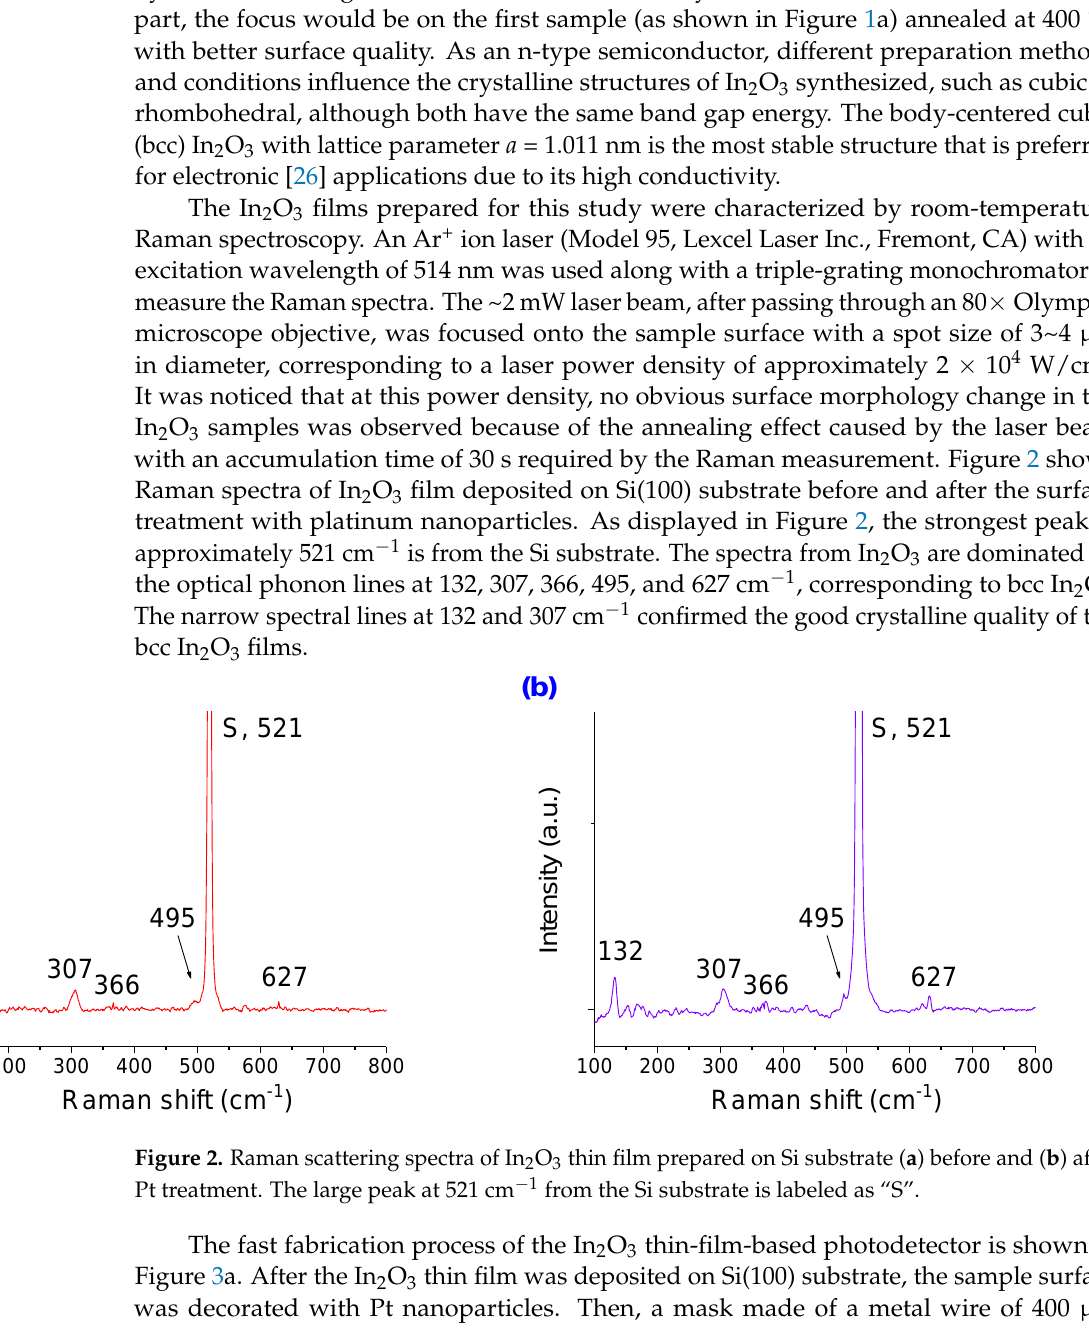
Figure 1. SEM images of In 2 O 3 samples annealed at ( a ) 400 °C, ( b ) 600 °C, and ( c ) 800 °C, respectively, for 2 h.